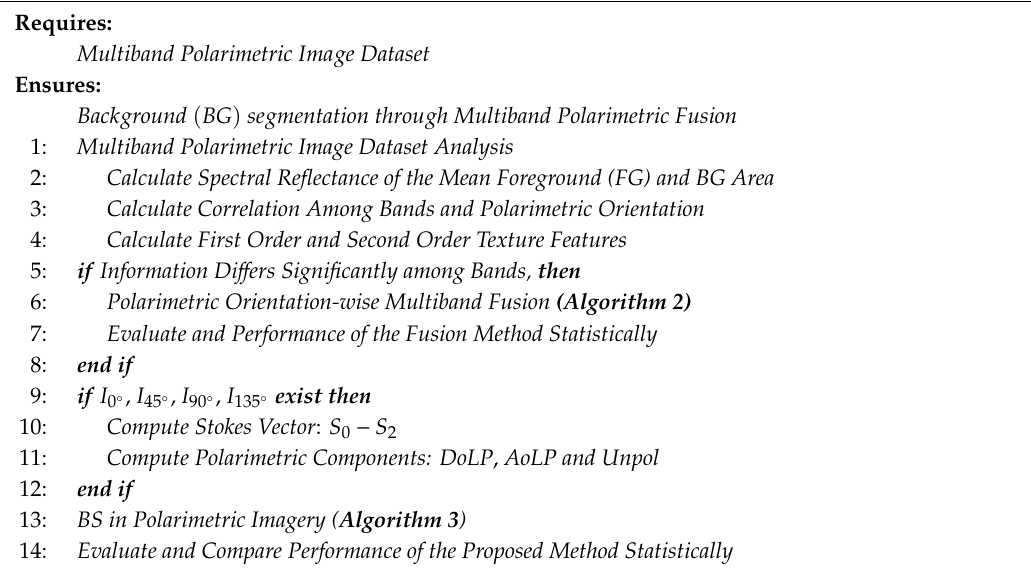
Algorithm 1. Multiband Fusion and BS